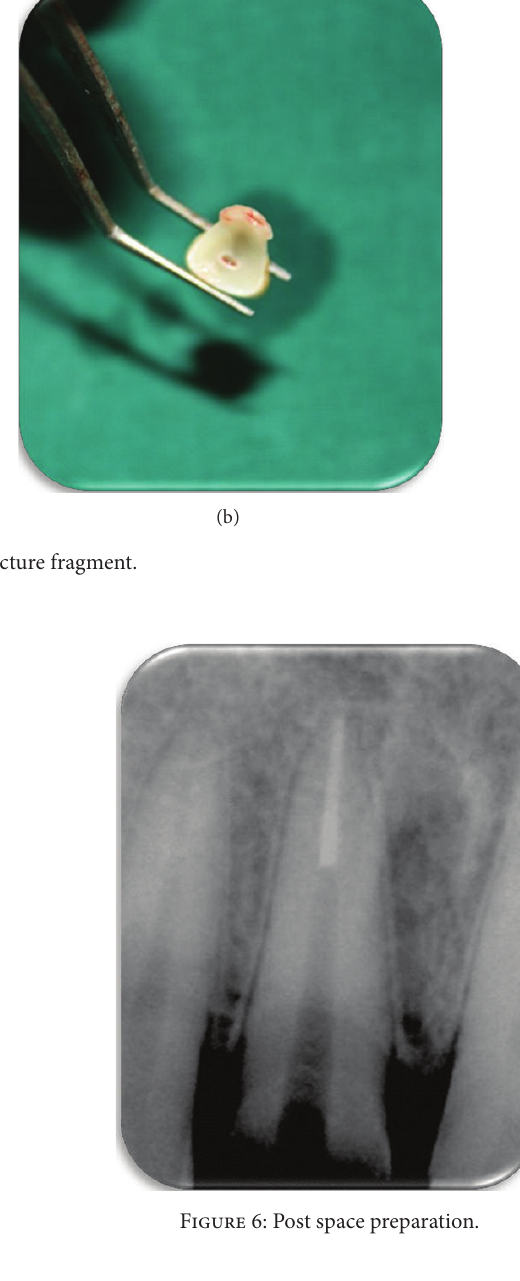
Figure 5: Obturation.